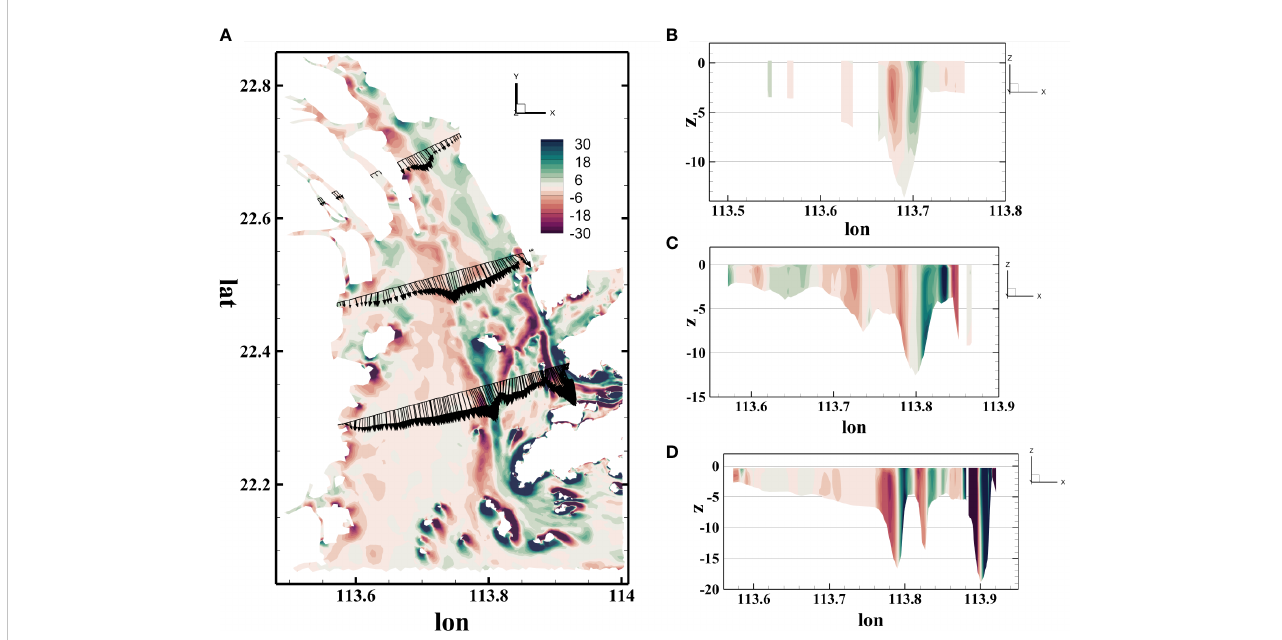
FIGURE 4 Vorticity map on the surface layer during ebb tide (A) and vorticity in the vertical direction of three cross-estuary sections ( B , north; C , middle; D ,